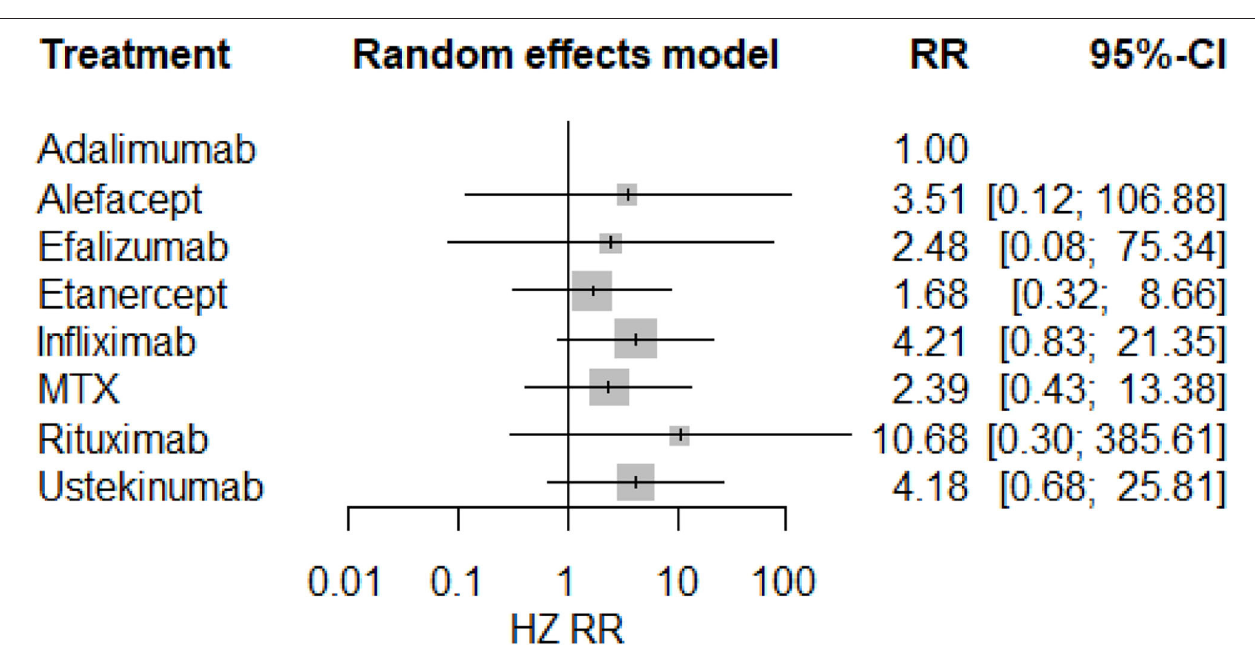
FIGURE 2 | Forest plots of network